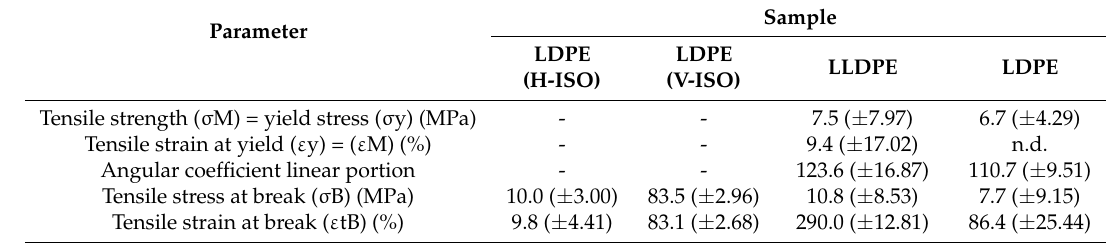
Table 5. Tensile test data obtained from ISO and dog-bone shaped specimens made of linear low-density polyethylene (LLDPE) and low-density polyethylene (LDPE) expressed as a mean ± %standard